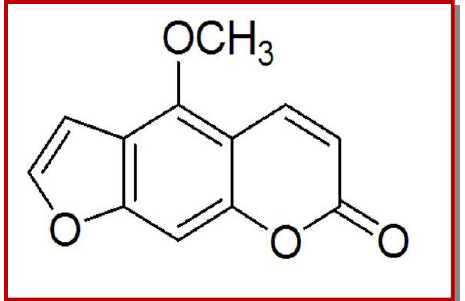
Figure 1: Molecular structure of